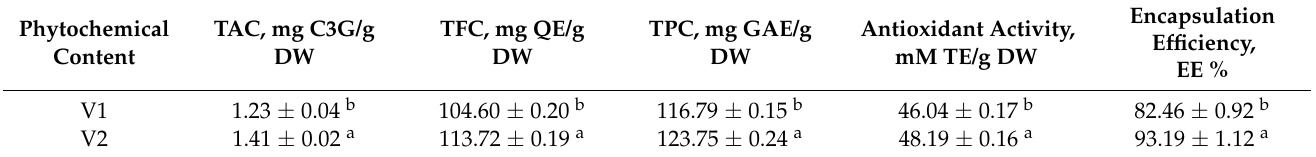
Table 1. Characterization of the phytochemicals of red OS